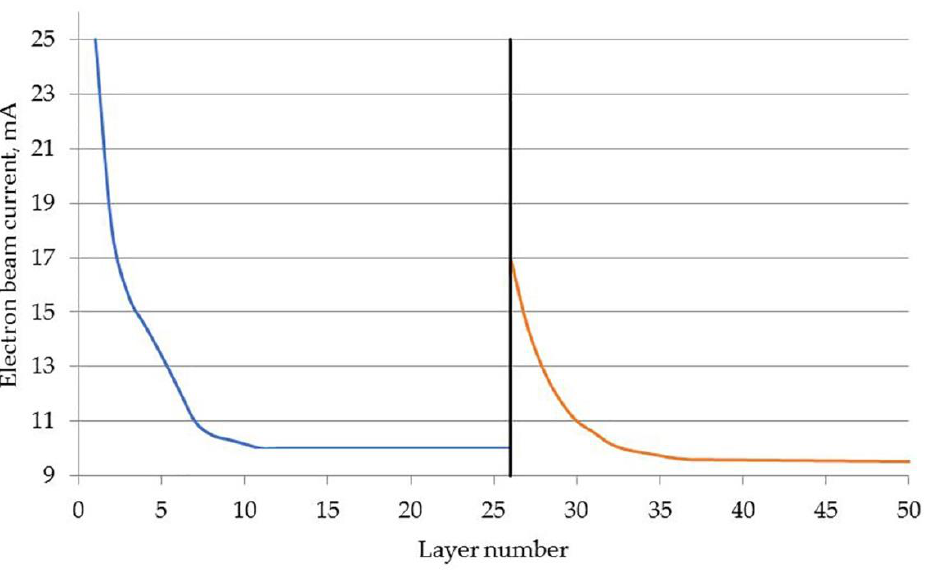
Figure 3. Changes in electron beam current during layer deposition. Blue line — formation of the initial wall, red line — formation of the repaired wall.